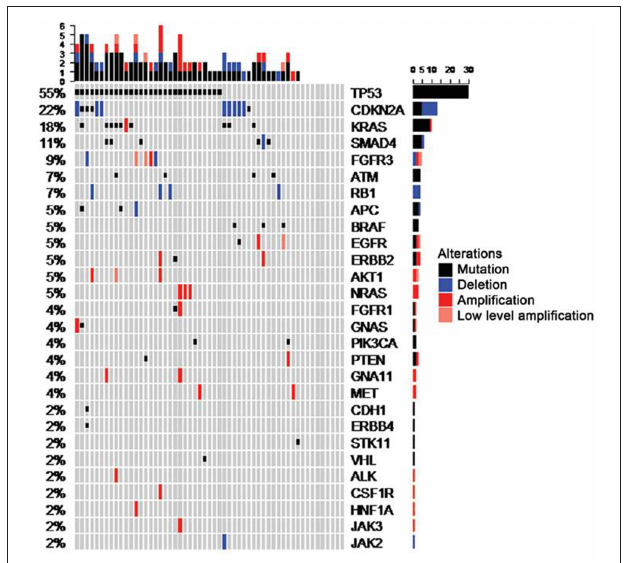
FIGURE 2 | shows the distribution of mutational spectra in CUP patients with adenocarcinoma and undifferentiated carcinoma types as detected in a prior study from our group, drawn from Loffler et al. (